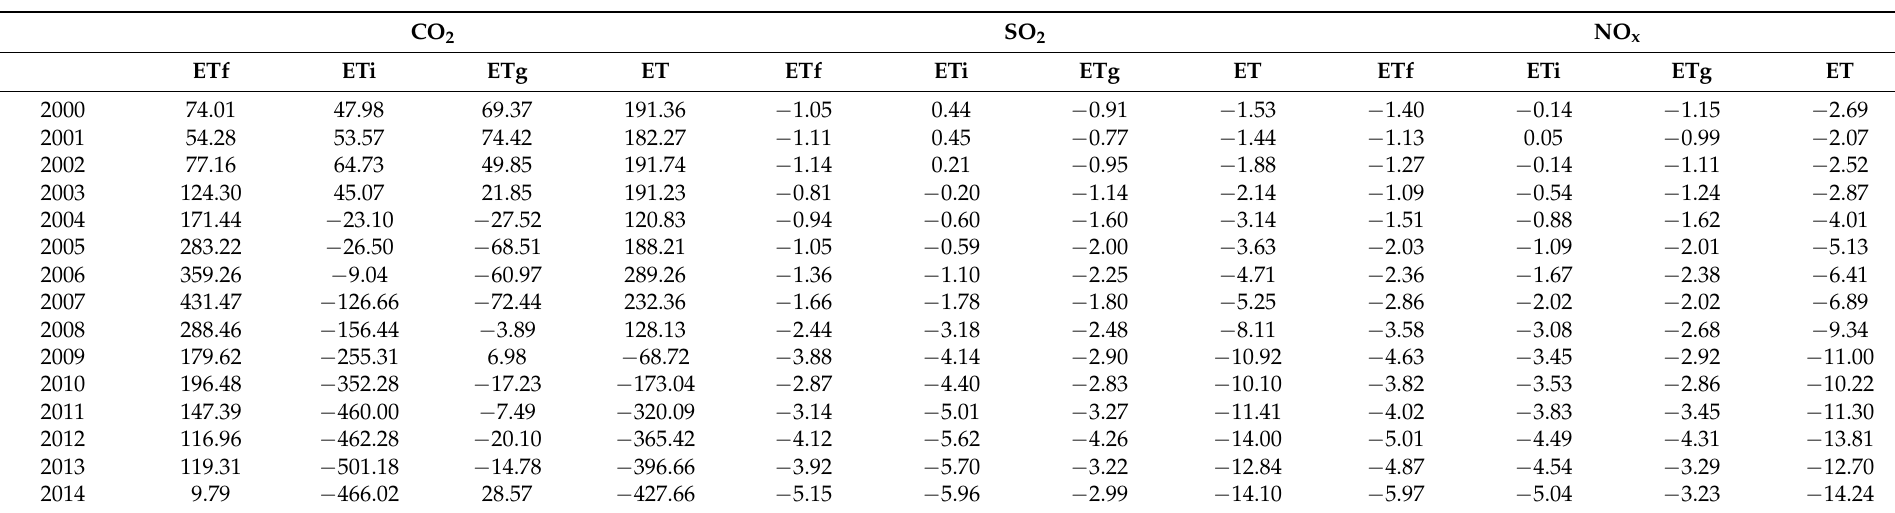
Table A5. Time evolution of global pollution haven under different trade patterns.